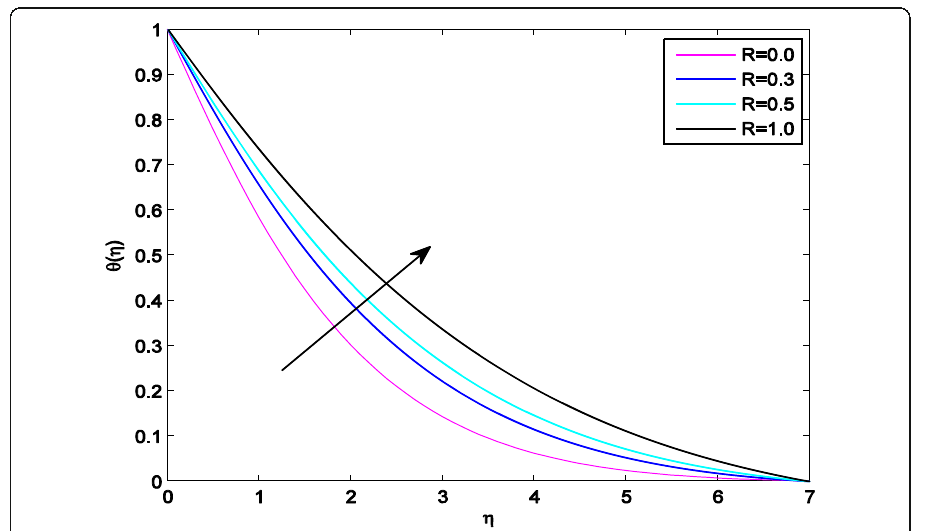
Fig. 20 Temperature graph for various values of